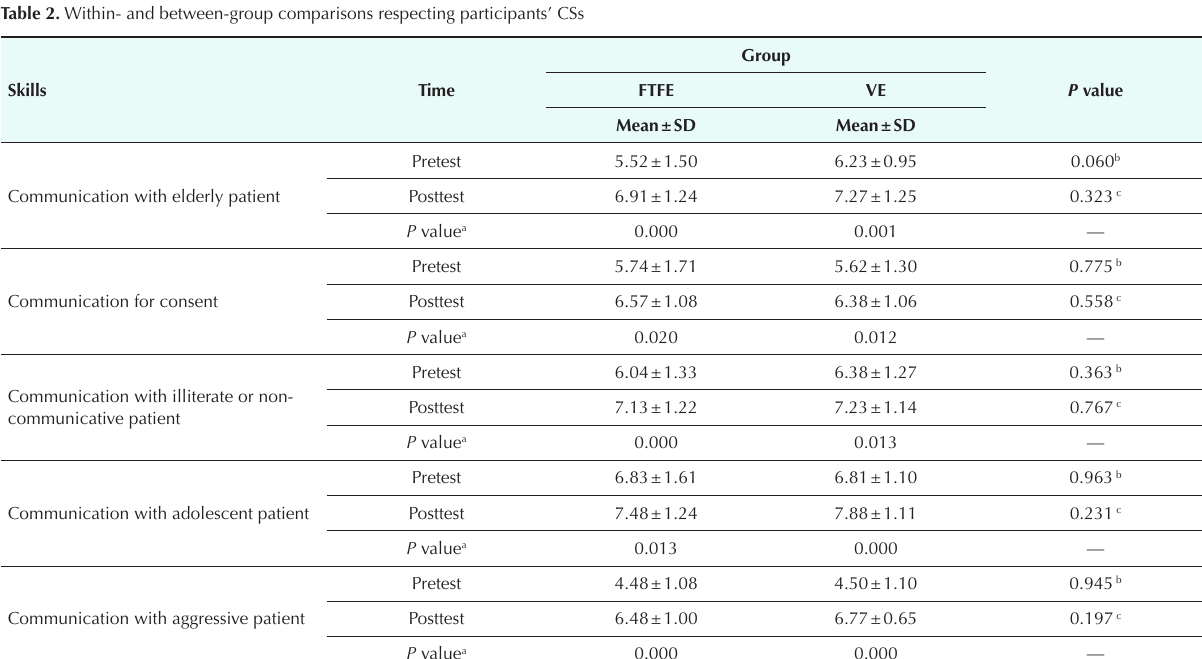
Table 2. Within- and between-group comparisons respecting participants’ CSs